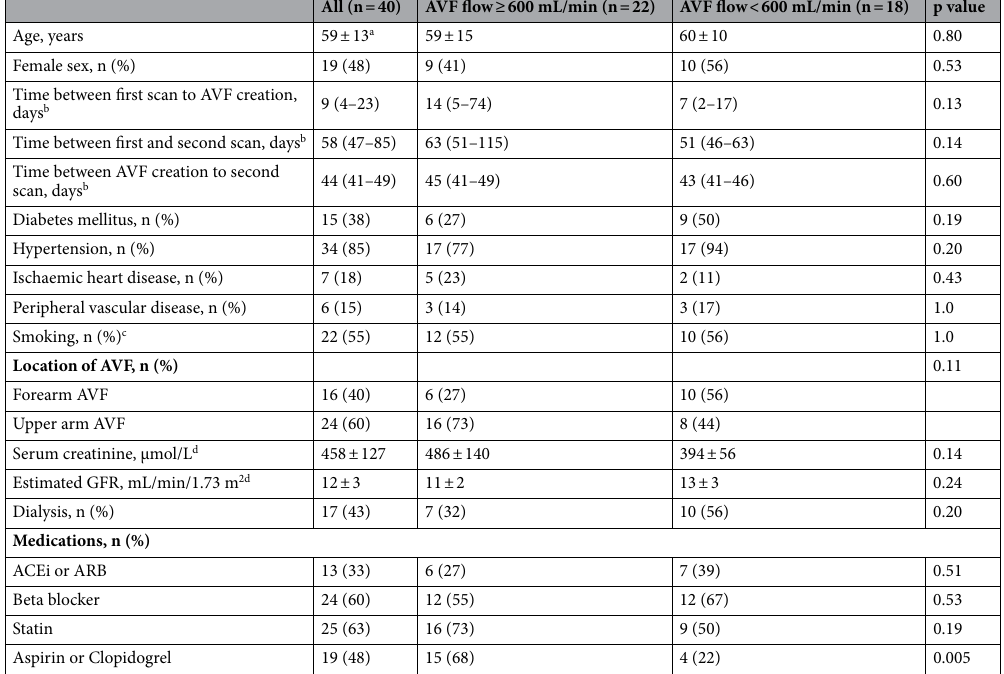
Table 1. Characteristics of the study participants at baseline. AVF arteriovenous fistula, GFR glomerular filtration rate calculated using Chronic Kidney Disease Epidemiology Collaboration (CKD EPI) formula, ACEi angiotensin converting enzyme inhibitor, ARB angiotensin II receptor blocker. a Plus-minus values are mean ± SD. b Median (IQR). c Current or previous. d Includes 23 non-dialysis participants.